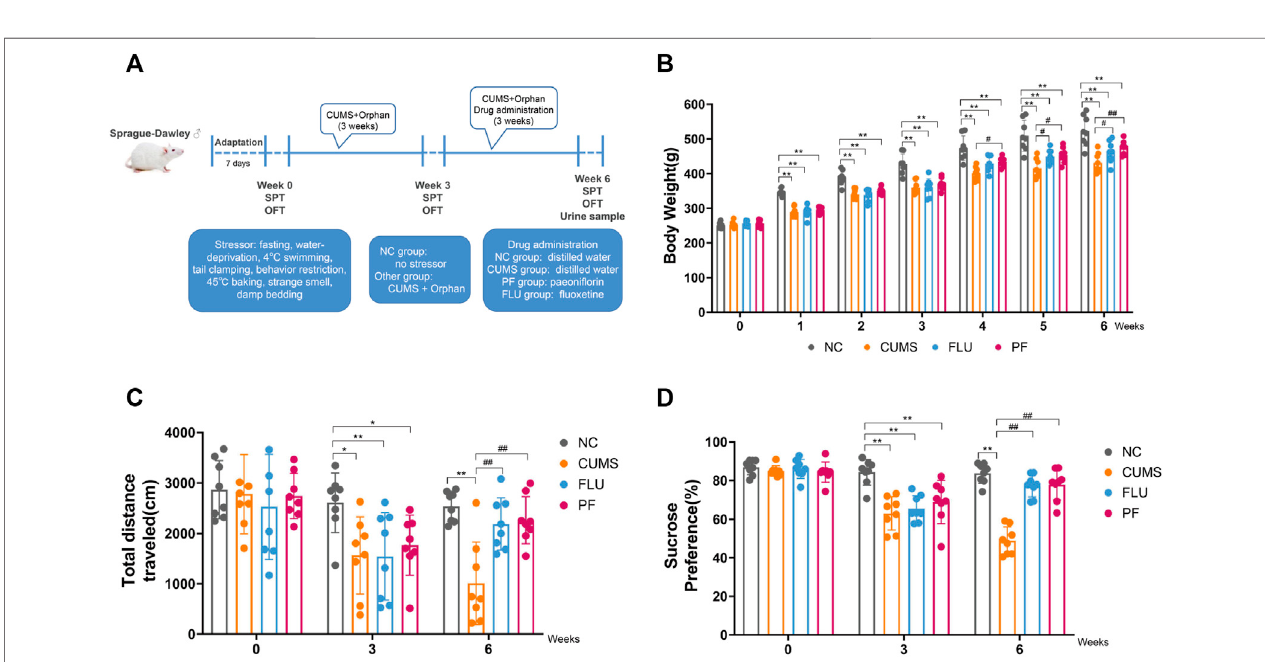
FIGURE1|(A) FlowchartforestablishingaCUMS-induceddepressionmodel. (B) BodyWeightsinvariousgroups. (C) Totaldistanceinvariousgroups. (D) Sugar consumption rates in various groups. Data are mean ± standard deviation, n = 8. * p < 0.05, ** p < 0.01 versus NC group; # p < 0.05, ## p < 0.01 versus CUMS